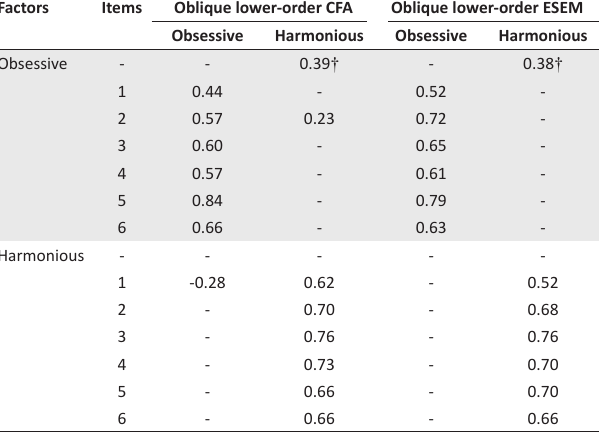
TABLE 4: Factor loadings of confirmatory factor analysis (with medication indices) and exploratory structural equation model solutions.